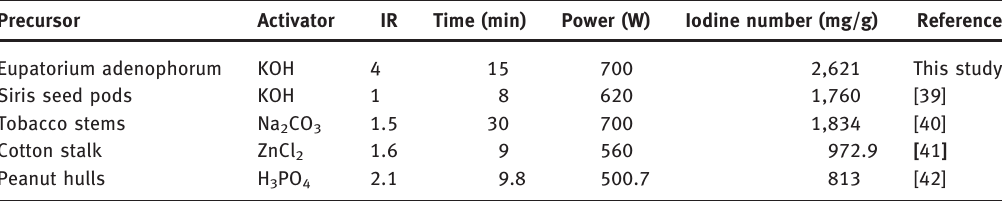
Table 5: The AC prepared from various raw materials by microwave heating with different activation agents.